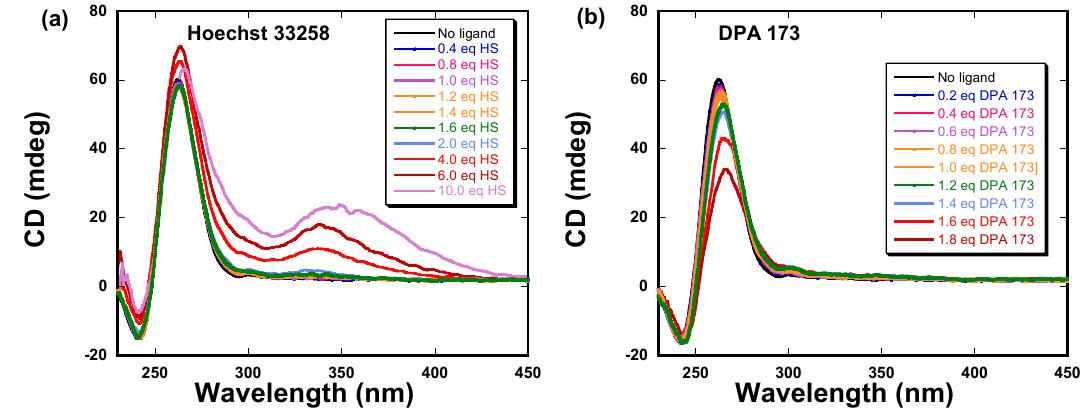
Figure 4. Circular dichroism studies of C-myc quadruplex with ( a ) Hoechst 33258 and ( b ) DPA 173.